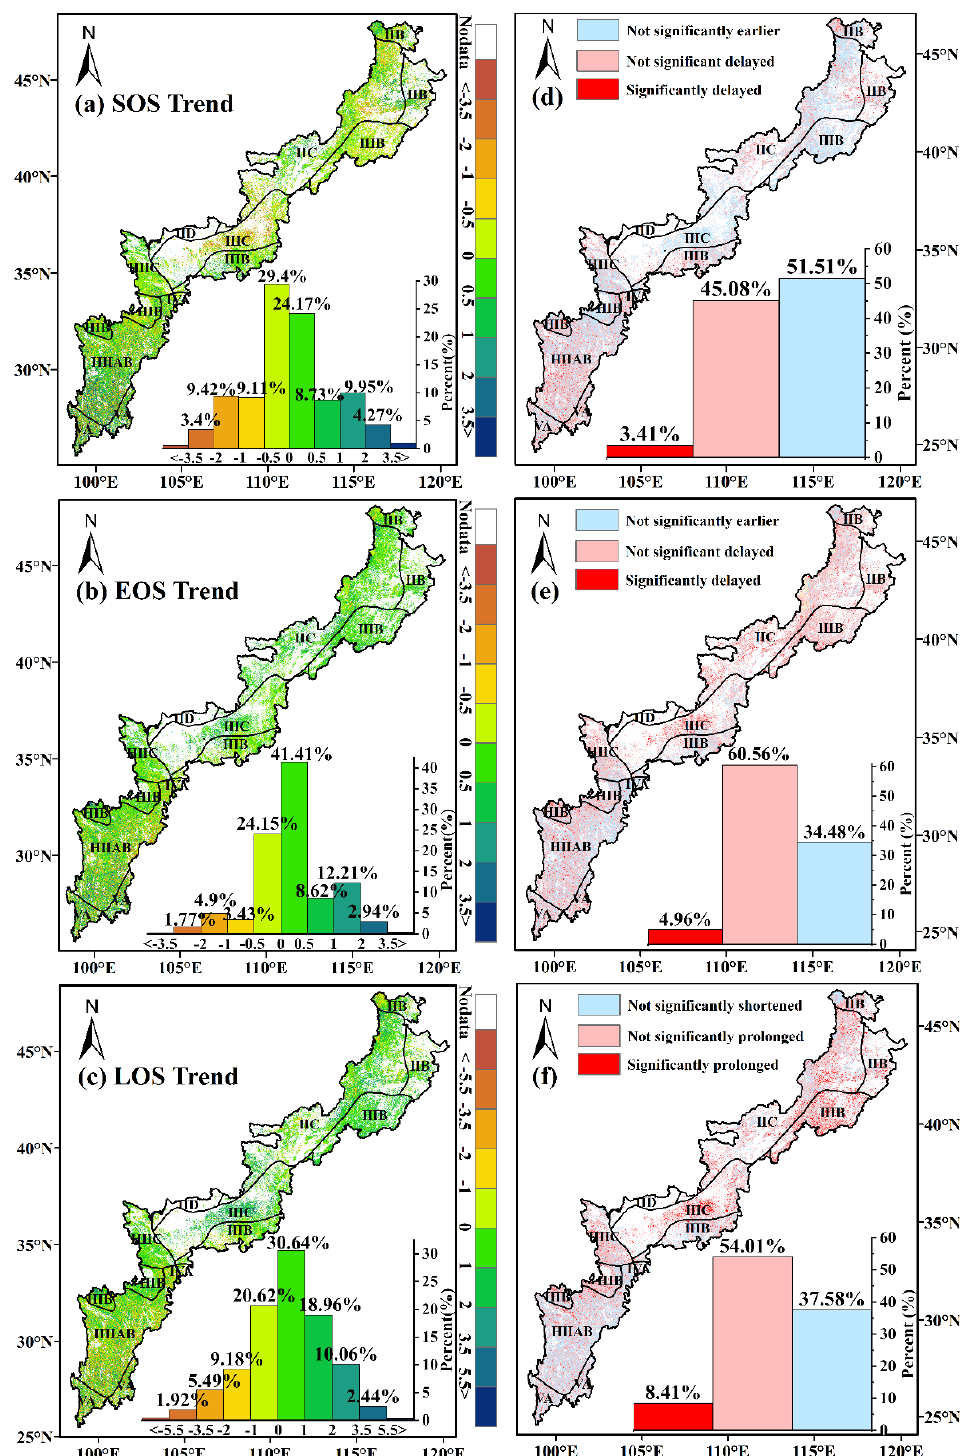
Figure 5. The interannual variation of the vegetation phenology in the agro ‐ pasture ecotone. ( a – c ) Spatial distribution of the interannual variation trends of the SOS, EOS, and LOS, between 2000 and 2020, respectively; ( d – f ) are the significances of the SOS ( d ), EOS ( e ), and LOS ( f ) obtained from the MK test for a period of 21 years, respectively.